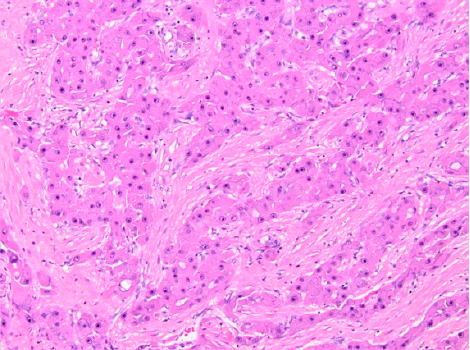
Figure 12. Fibrolamellar type hepatocellular carcinoma (H&E, 10×). Malignant proliferation of hepatocytes with abundant, granular eosinophilic cytoplasm with prominent nucleoli, set in a fibrotic